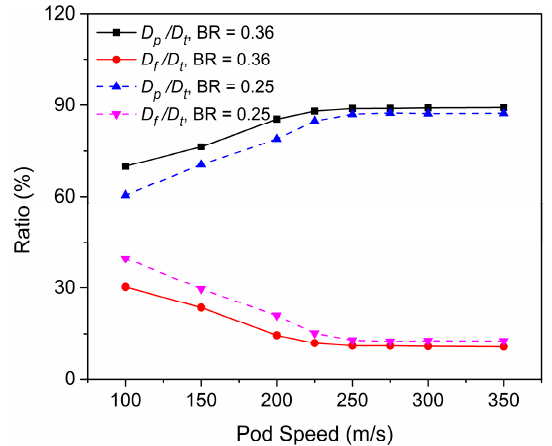
Figure 7. Ratios of the pressure and friction drags to the total drag. The results are similar to those of Oh et al. (2019) [5], who conducted steady-state simulations.